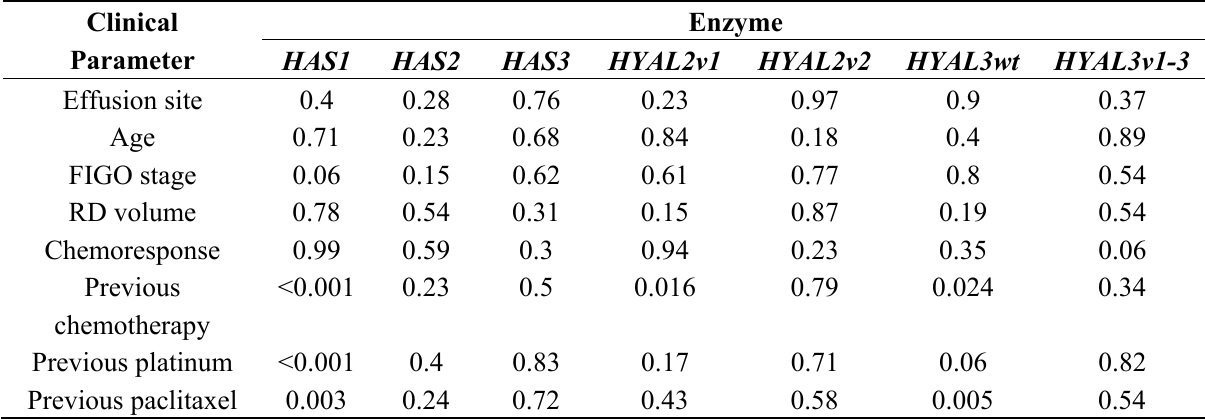
Table 2. The association between clinicopathologic data of the effusion cohort and HAS/HYAL expression ( p